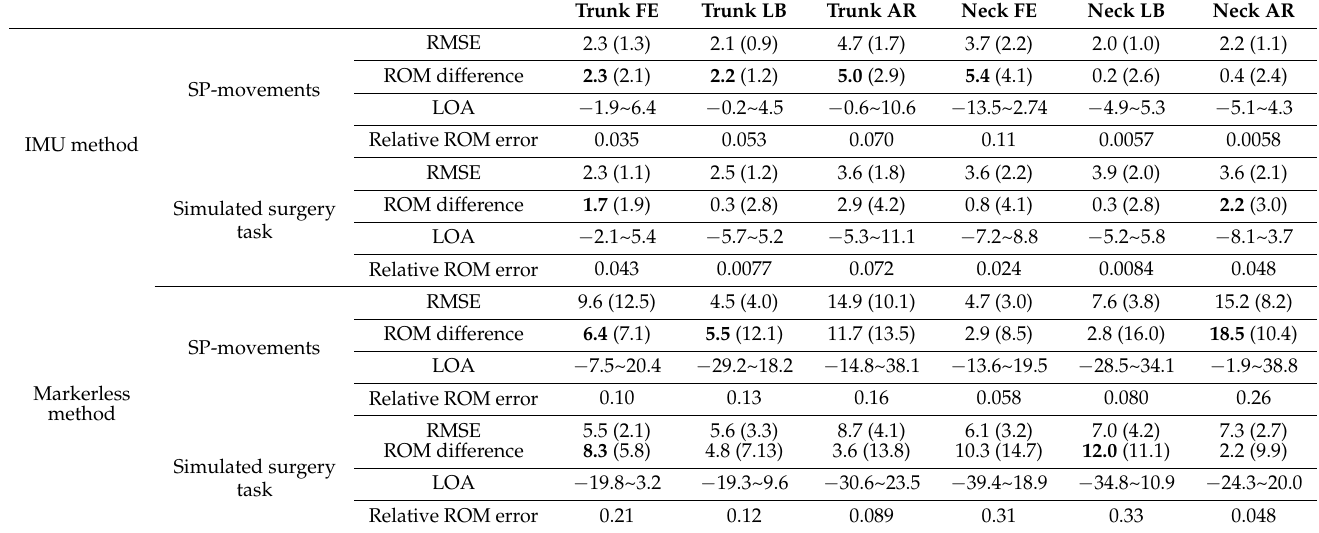
Bold values indicate a significant difference between the IMU/Markerless method and the gold